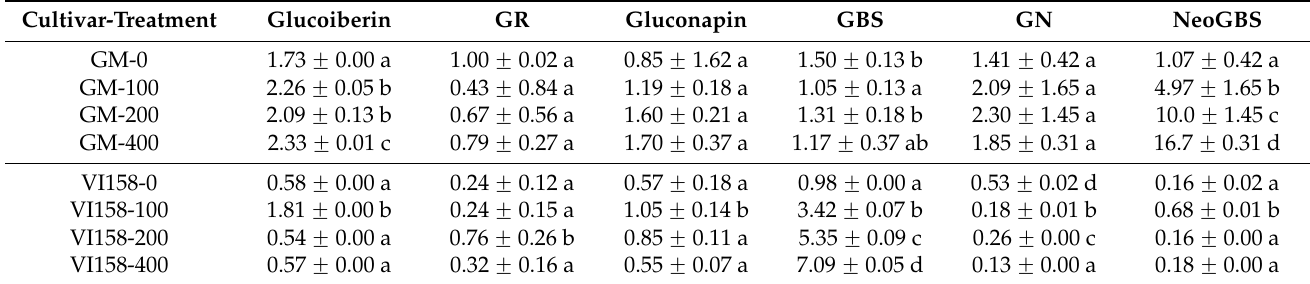
Table 1. Glucosinolate profiles ( µ M/g DW) of two broccoli cultivars treated with different JA concentrations ( µ mol/L). Different letters from right side of values indicate differences between treatments within a cultivar for a given glucosinolate according to Fisher’s LSD tests ( p = 0.05). Abbreviations: GM = Green Magic, GR = glucoraphanin, GBS = glucobrassicin, GN = gluconasturtiin, NeoGBS = neoglucobrassicin.